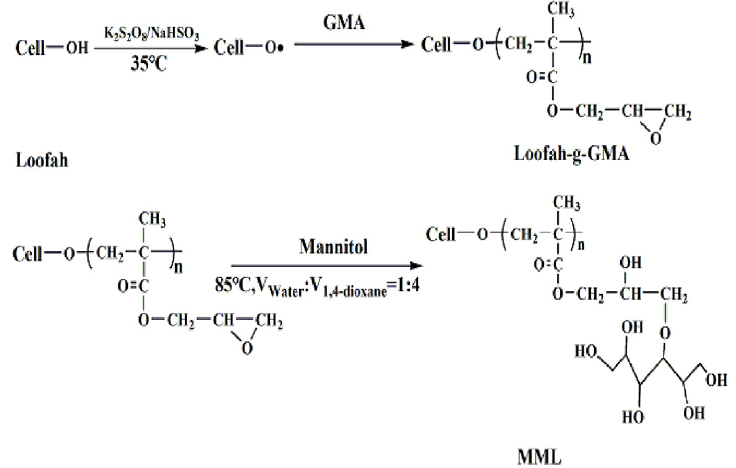
Figure 1. The principle of MML preparation.